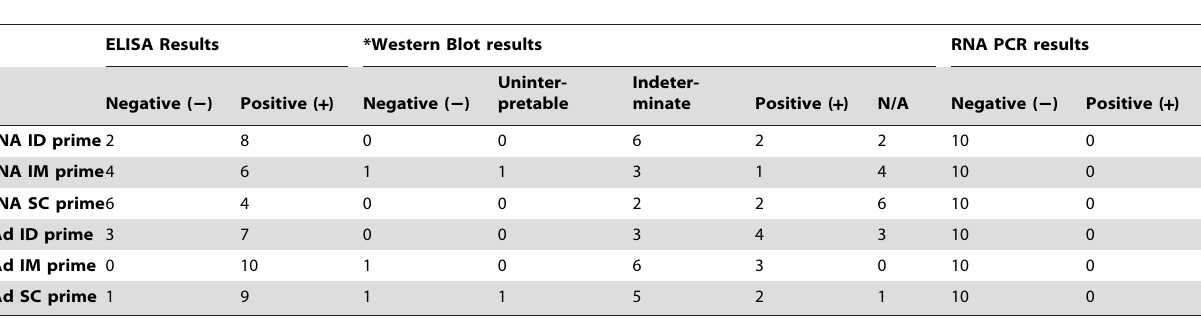
Table 5. Frequency of Vaccine-Induced Seropositivity/Reactivity Through Study Week 42.